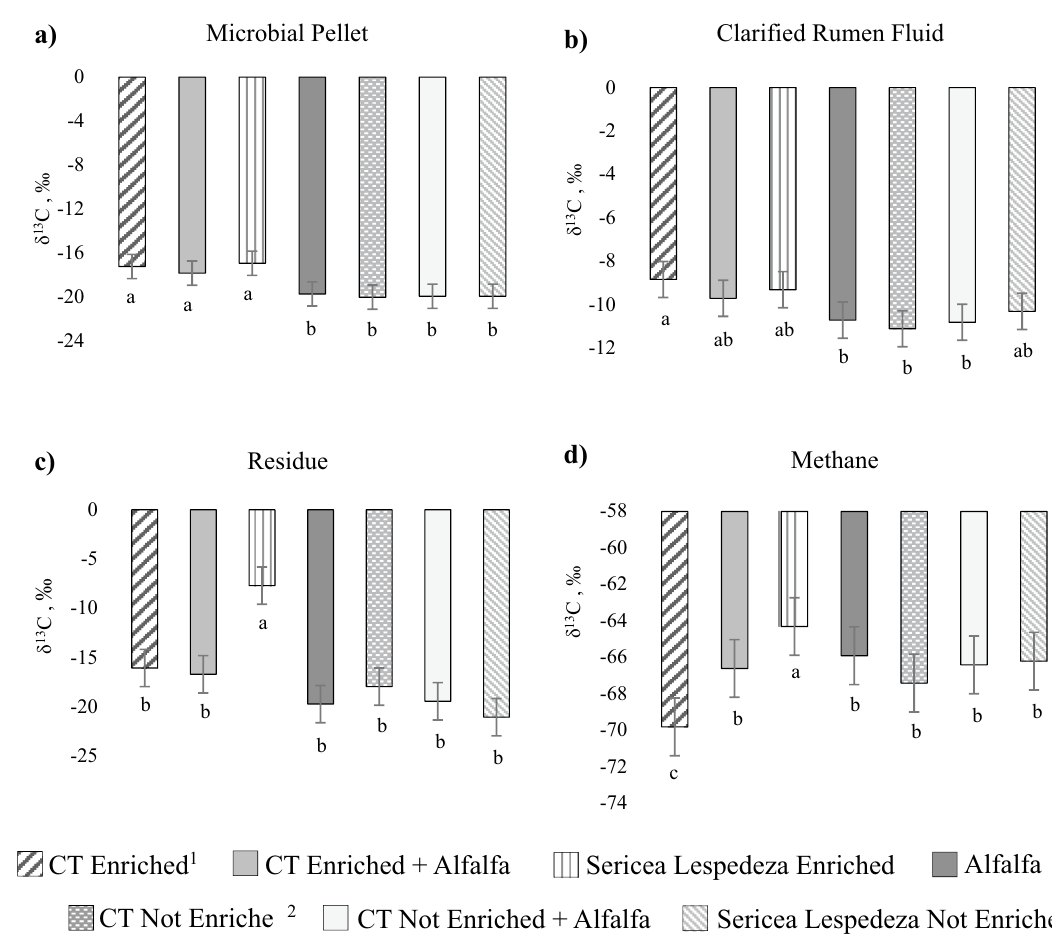
Figure 2. Effects of enrichment of sericea lespedeza [ Lespedeza cuneata (Dum. Cours.) G. Don] with 13 C–CO 2 on ( a ) microbial pellet, ( b ) clarified rumen fluid, ( c ) residue pellet, and ( d ) methane from in vitro fermentation from Trial 2. Isotopic composition of end-products of fermentation determined with isotope ratio mass spectrometry. 1 CT enriched: condensed tannins enriched with 13 C–CO 2 . 2 CT not enriched: condensed tannins not enriched with 13 C–CO 2 . Means with different letters are significantly different by Tukey test ( P < 0.05). Bars refer to the standard error.